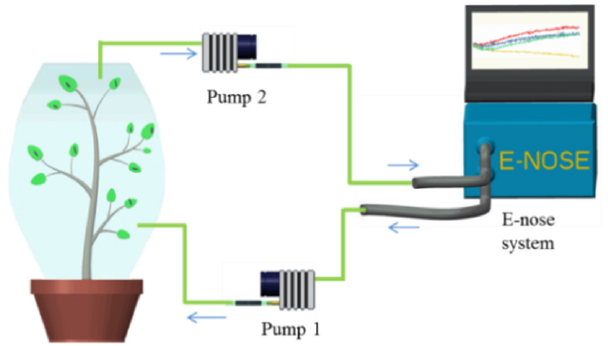
Figure 3. Illustration of tomato plant detection using the E-nose system. Tomato plants were cultivated under the three different treatments of whitefly infes- tation, mechanical damage, and no stress (control group). Before testing, selected plant samples were covered with Teflon bags for about an hour to generate headspace air.